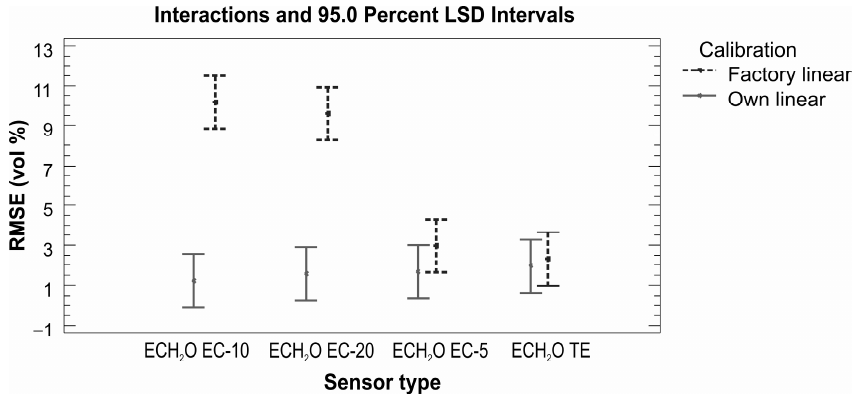
Figure 10. Sensors from the ECH 2 O family—sensor performance comparison based on RMSE (vol %) values for factory and our own calibrations.